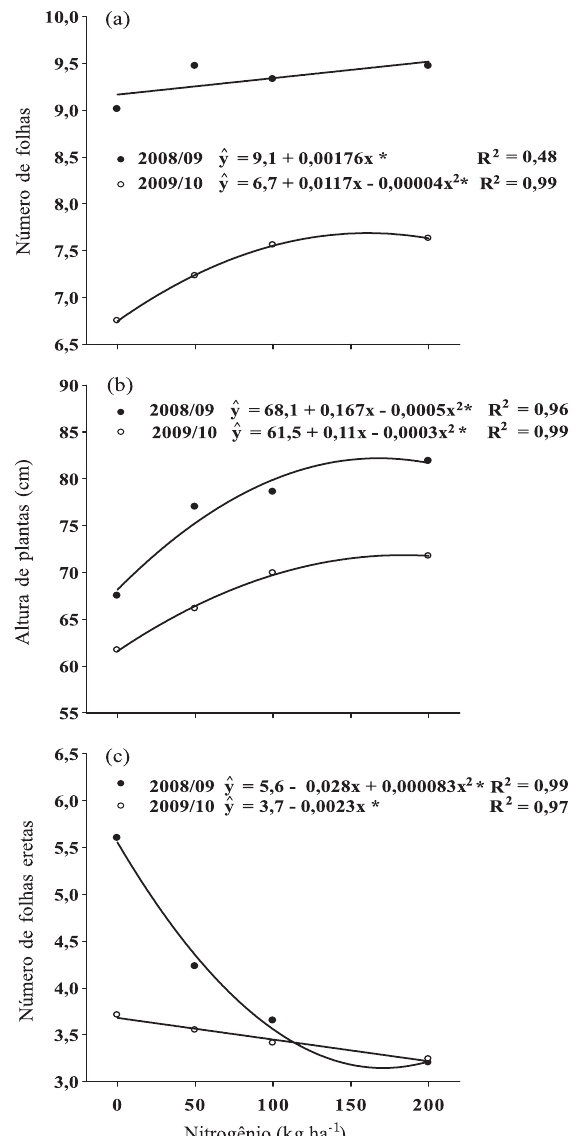
Figura 3. perda pós-colheita de bulbos de cebola em função da adição de doses crescentes de nitrogênio ao solo, em duas safras. *: significativo (p ≤ 0,05); ns: não